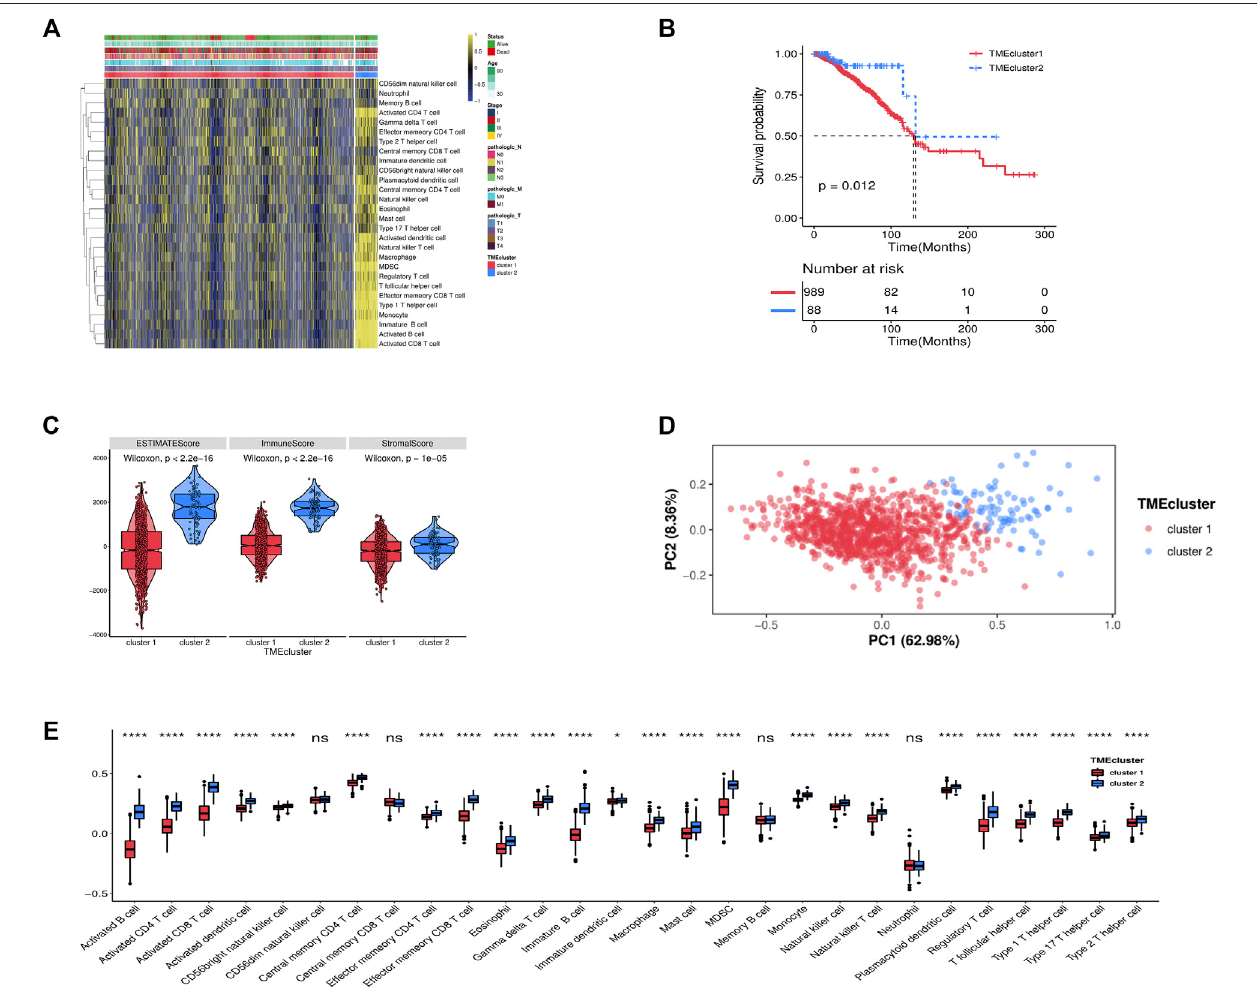
FIGURE1|(A) Unsupervised clustering ofTME cellsfor1,077patientsintheTCGA cohort. (B) Kaplan-Meiercurves forOSof1,077patientsinTCGA cohort (log- rank test, p < 0.001). (C) Expression difference of ESTIMATE score, Immune Score, Stromal Score, and Tumor Purity in two clusters. (D) Principal component analysis (PCA) of two TME clusters modi fi cation pattern. (E) The fraction of TME cells in two clusters. The statistical difference of two TME clusters was compared through the Kruskal-Wallis test. * p < 0.05 ; **, p < 0.01 ; ***p < 0.001 ; ****p < 0.0001 .